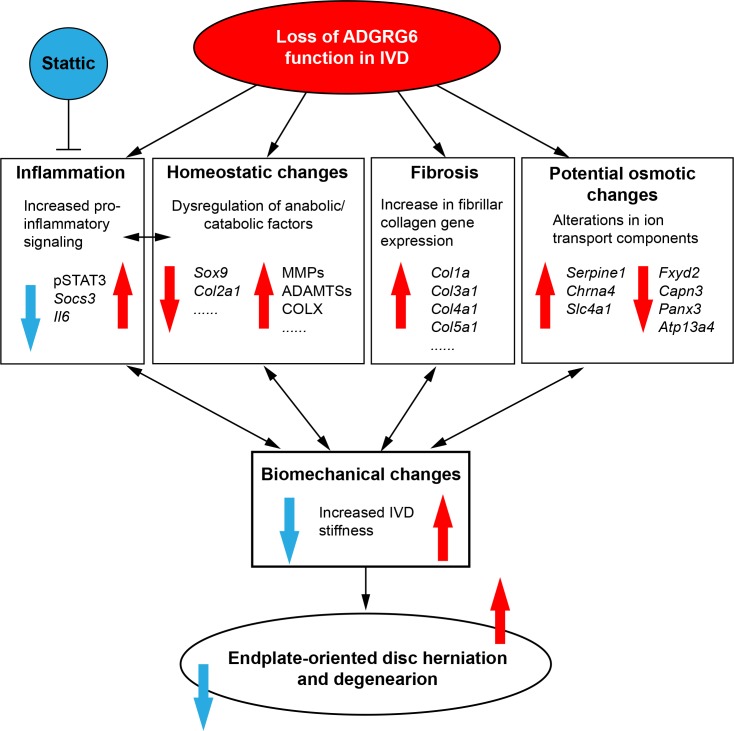
A model of ADGRG6 in regulating IVD integrity.Loss of ADGRG6 function in cartilaginous tissues of the IVD leads to increased pro-inflammatory singling (especially STAT3 signaling), dysregulation of anabolic and catabolic factors, fibrosis of the disc, and potential osmotic changes of the disc in young mice. These changes synergistically weaken the IVD and result in altered biomechanical changes (increased disc stiffness), and ultimately leads to endplate-oriented disc herniation in adult mice. Inhibition of STAT3 signaling by Stattic treatment can alleviates the formation of disc herniations and partially rescue the disc stiffness upon loss of ADGRG6 function.